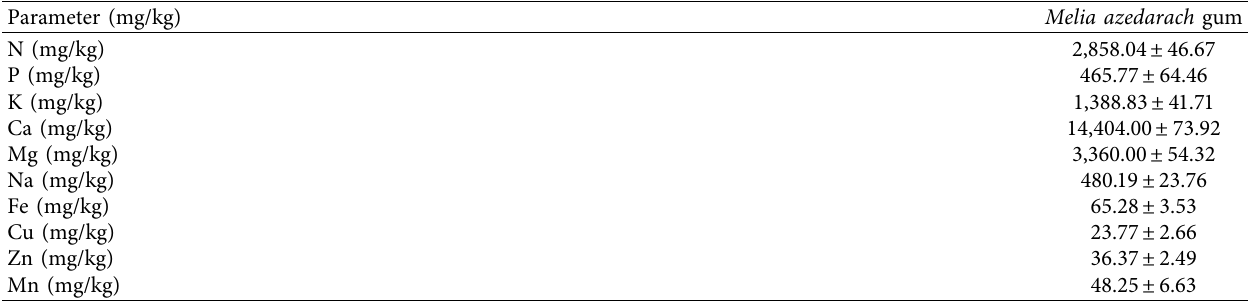
Table 3: Metal ions analysis of Melia azedarach gum.